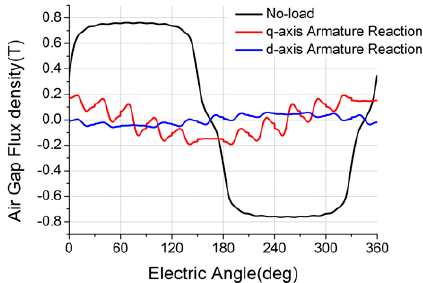
Figure 6. Air-gap flux density in the middle of the slotless air gap caused by permanent magnet, q-axis current and d-axis current respectively.